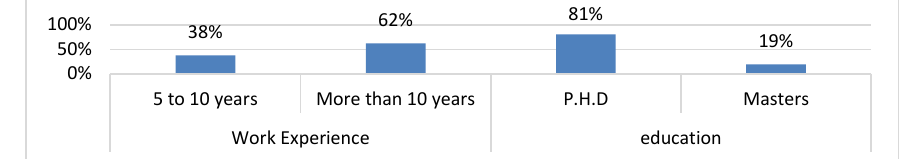
Figure 2. Status of work experience and education of